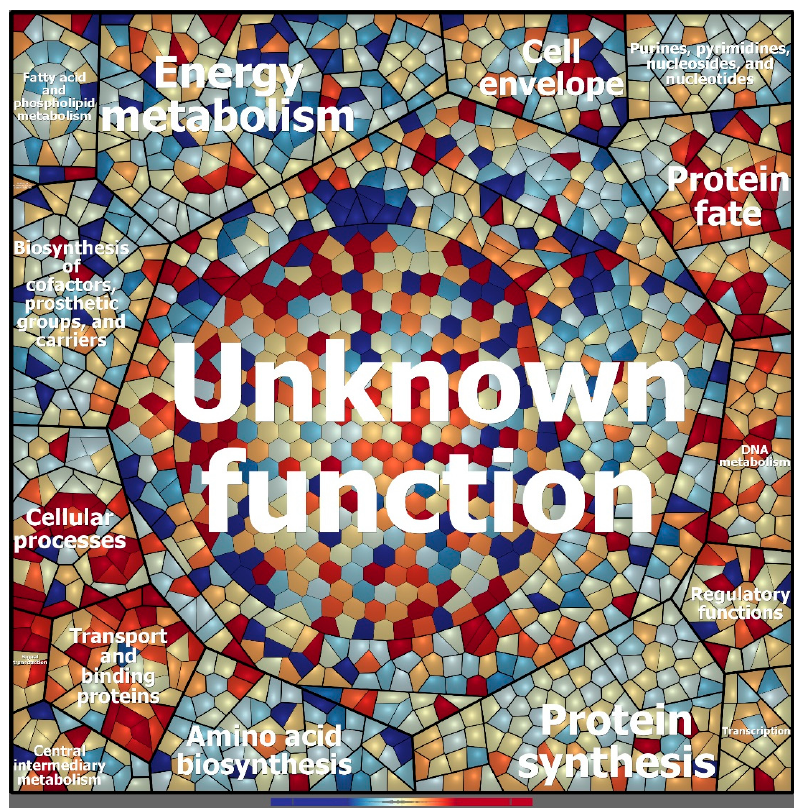
Figure 5. Voronoi treemap visualization of the protein expression patterns of Granulicella sp. WH15 under low and high sugar conditions. Functional classification was conducted using Prophane 2.0 (www.prophane.de) and is based on TIGRFAMs, where the function level indicates “main role” and the B function level indicates “subrole”. Each cell represents a quantified protein; proteins are